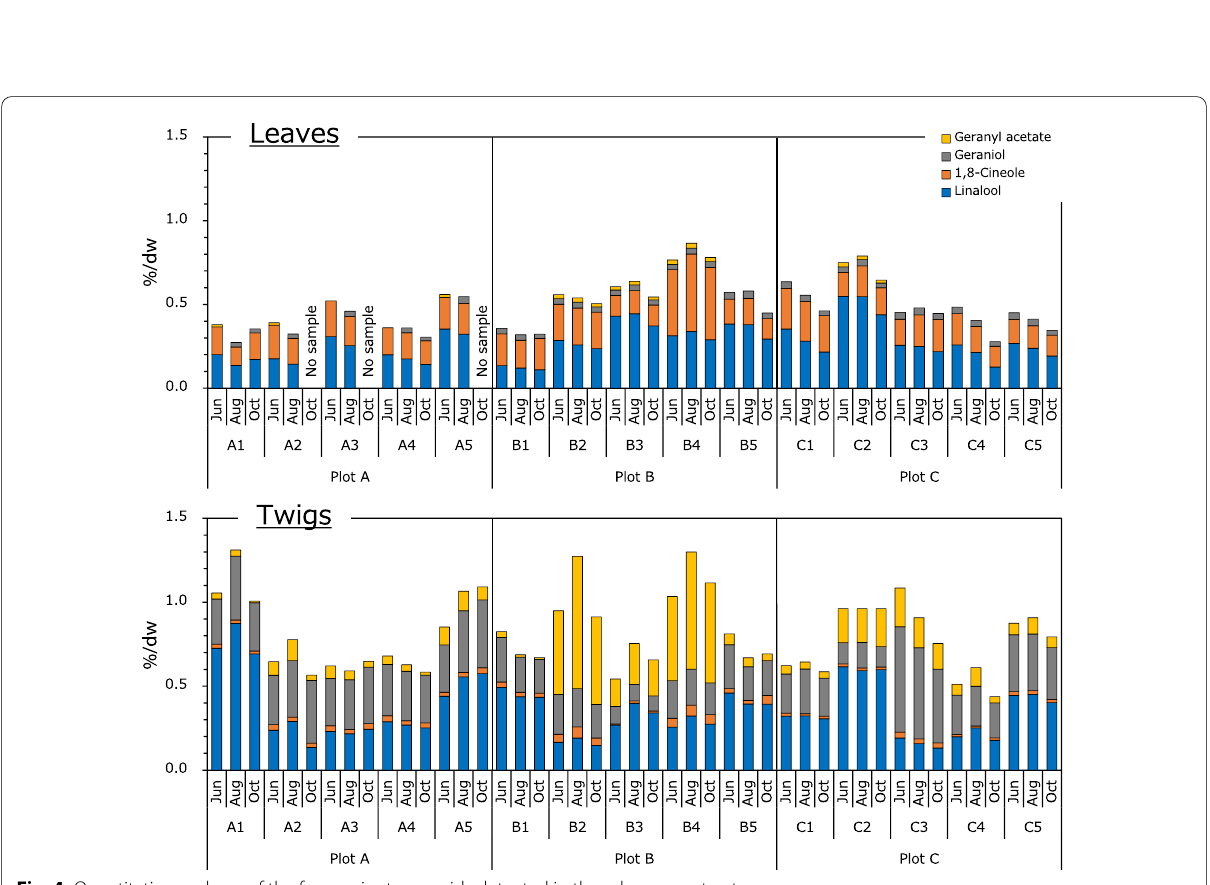
Fig. 4 Quantitative analyses of the four major terpenoids detected in the n -hexane